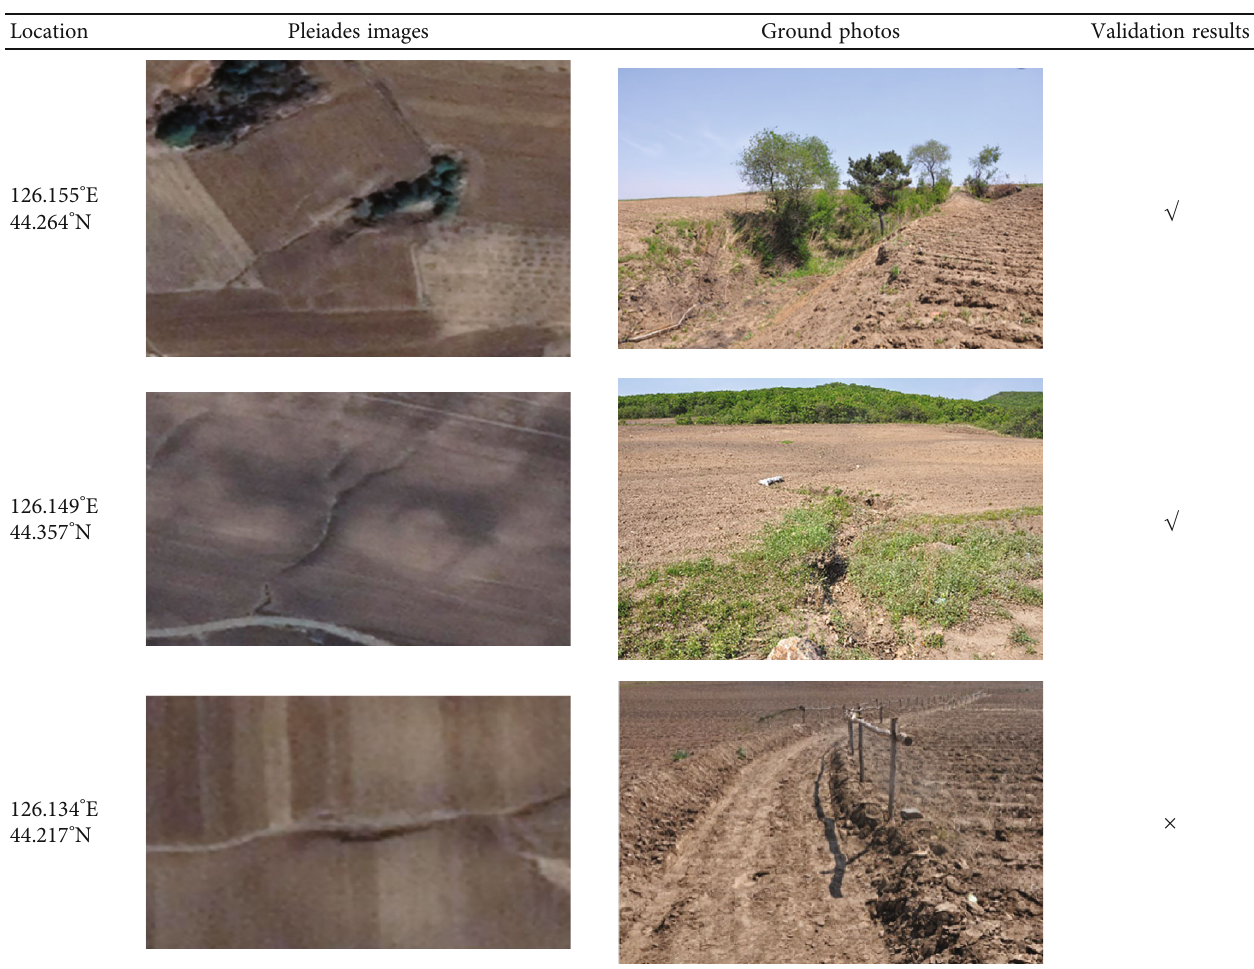
Table 4: Examples of validation